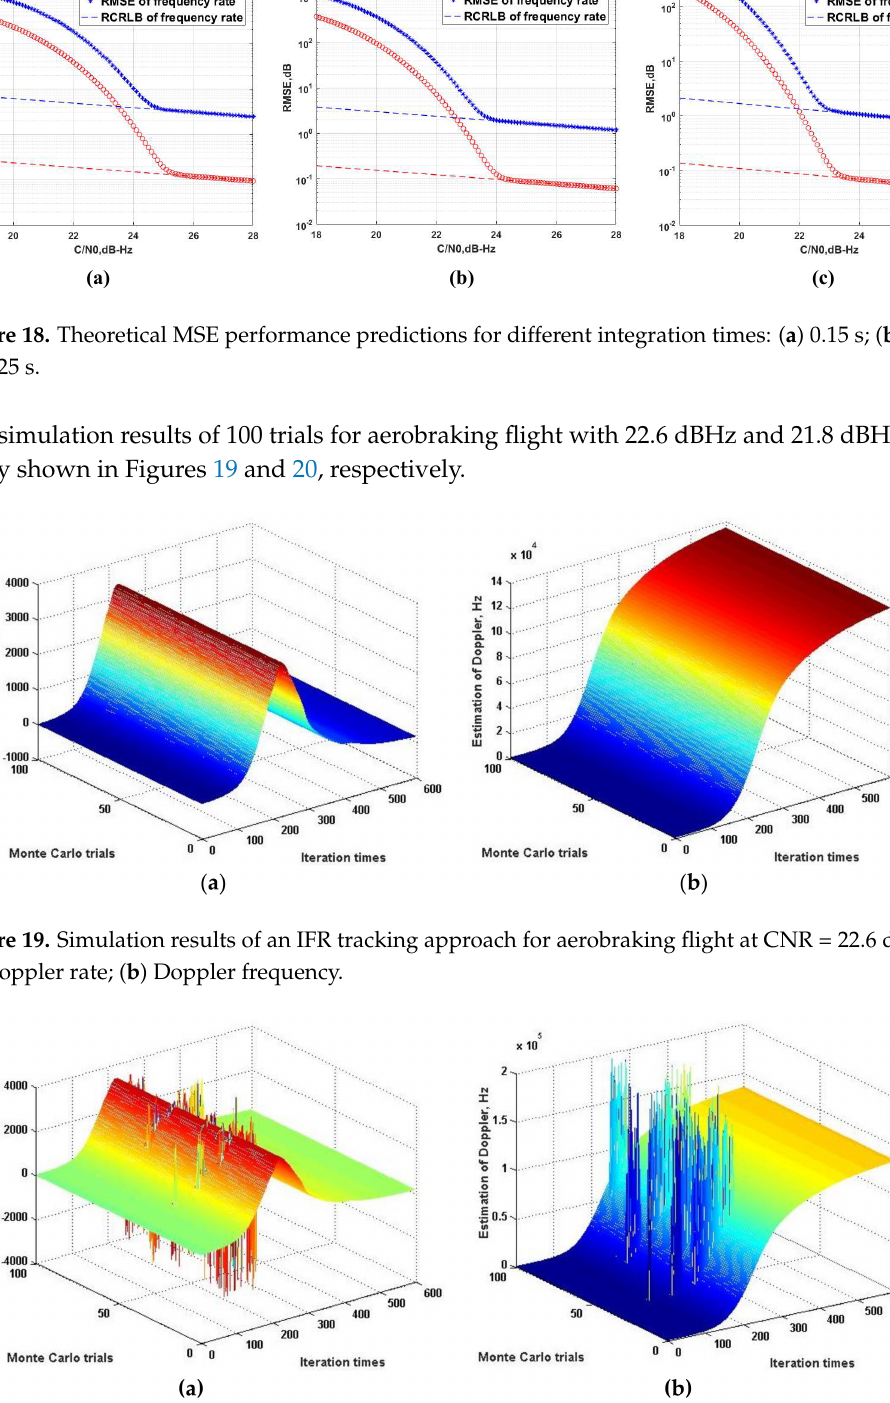
Figure 20. Simulation results of an IFR tracking approach for aerobraking flight at CNR = 21.8 dB-Hz: ( a ) Doppler rate; ( b ) Doppler